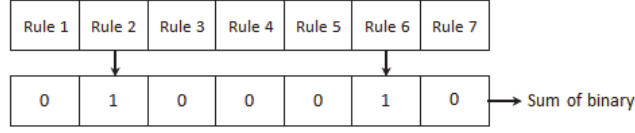
Fig. 3. Rules selection method by using GA